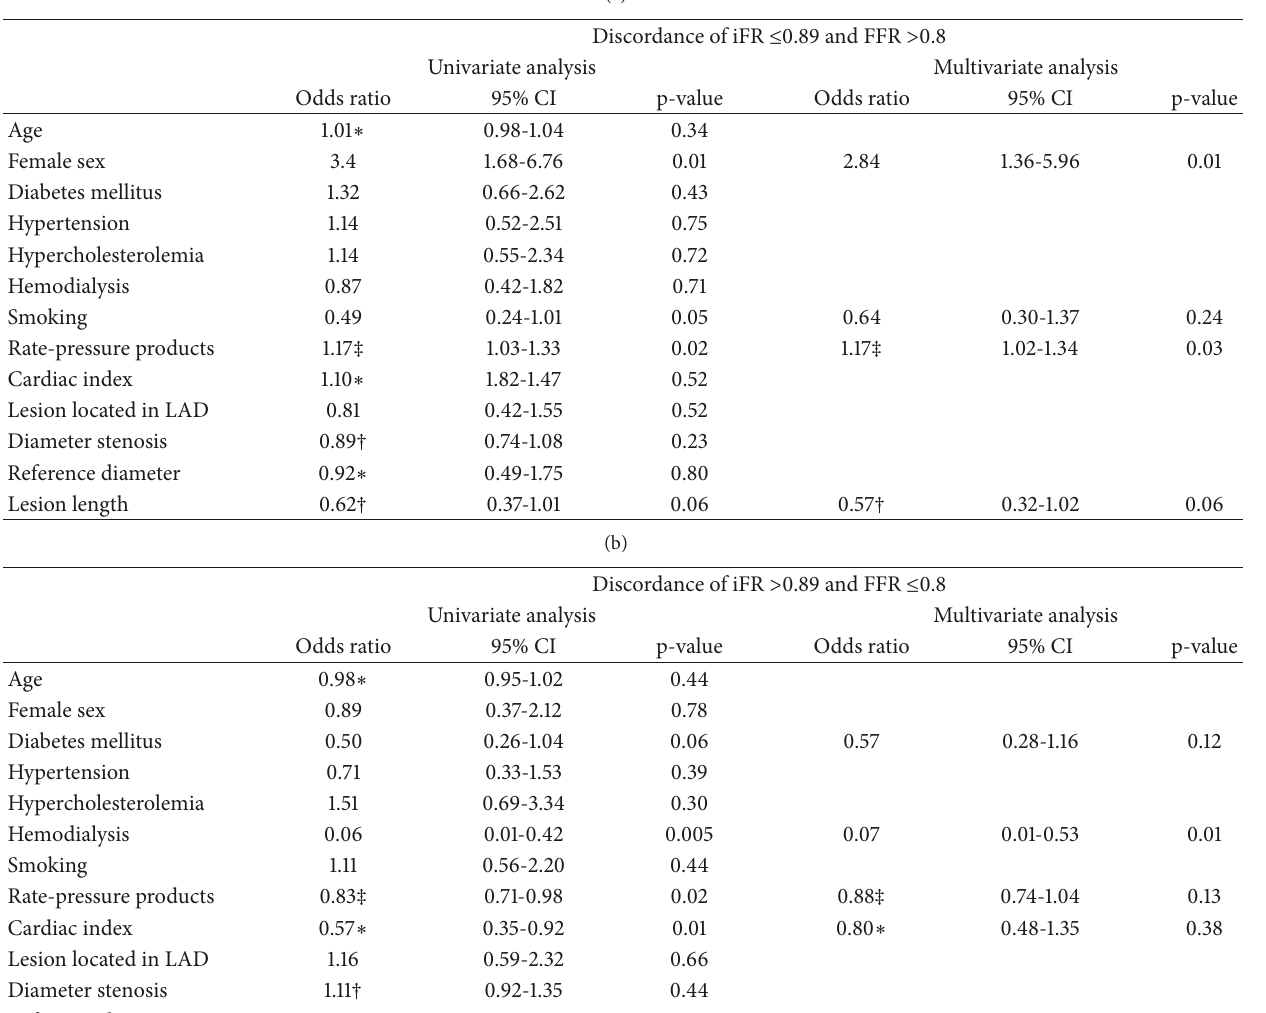
(a) Discordance of iFR ≤ 0.89 and FFR >